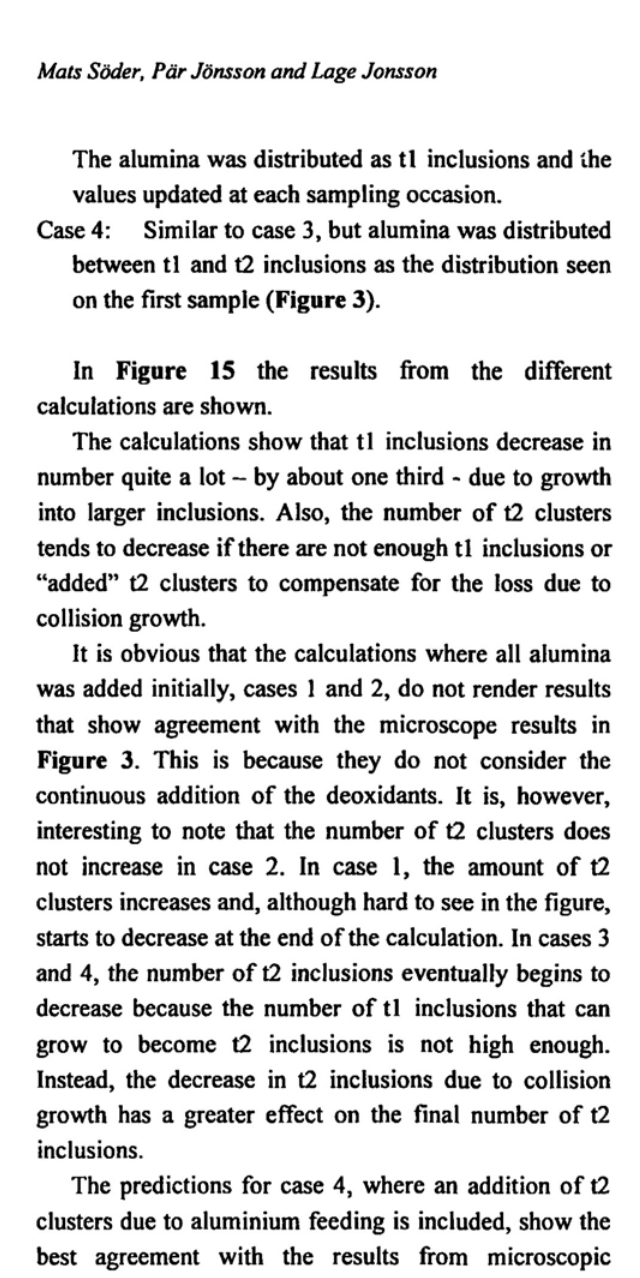
Fig. 16: Calculation case 4: results modified with assumed t2 addition from the number of t3- tI2